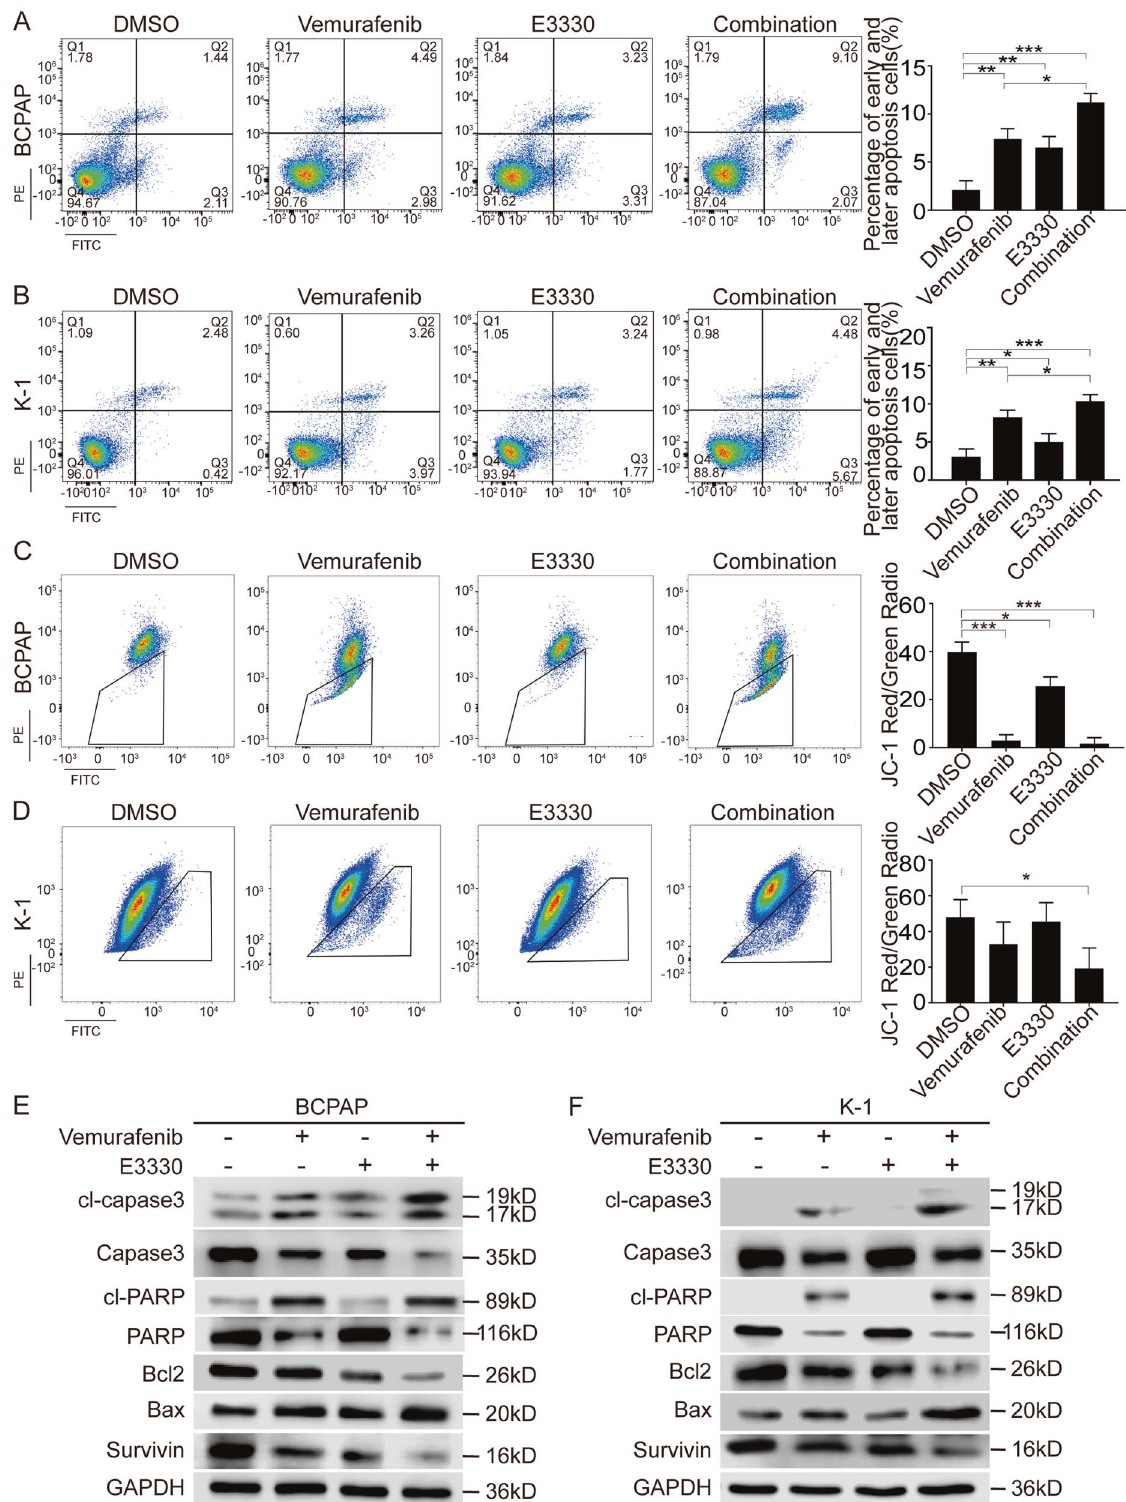
Fig. 4 E3330 enhanced the proapoptotic capacity of vemurafenib in BCPAP and K-1 cells. A , B The cell apoptosis rate measured by fl ow cytometric analysis in BCPAP and K-1 cell lines. C , D The mitochondrial membrane potential evaluation by detecting JC-1 content in BCPAP and K-1 cell lines. E , F Mitochondrial apoptosis pathway-associated protein expression detection by western blot assay in BCPAP and K-1 cell lines. BCPAP and K-1 cell lines were pretreated with DMSO, vemurafenib (10 μ M), E3330 (50 μ M), and combination (10 μ M vemurafenib + 50 μ M E3330), respectively. * P < 0.05, ** P < 0.01, *** P < 0.001.